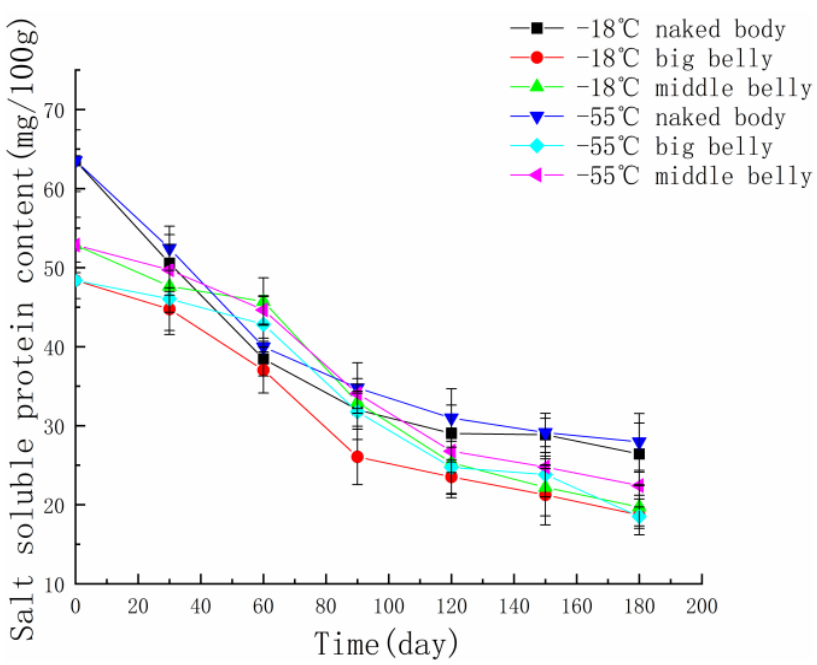
Figure 4. The changes in salt-soluble protein content in different parts of tuna during frozen storage at different temperatures.